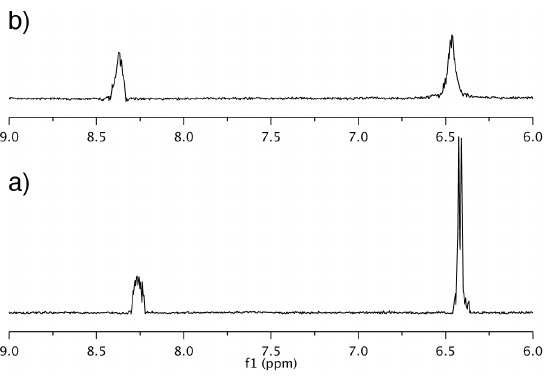
Figure 14. 1 H NMR spectra of NC0 α CD ; ( a ) alone and ( b ) in the presence of 1-AdOH showing the region of NBD protons; [NC0 α CD ] = [ 1-AdOH ] = 5 × 10 − 4 M.